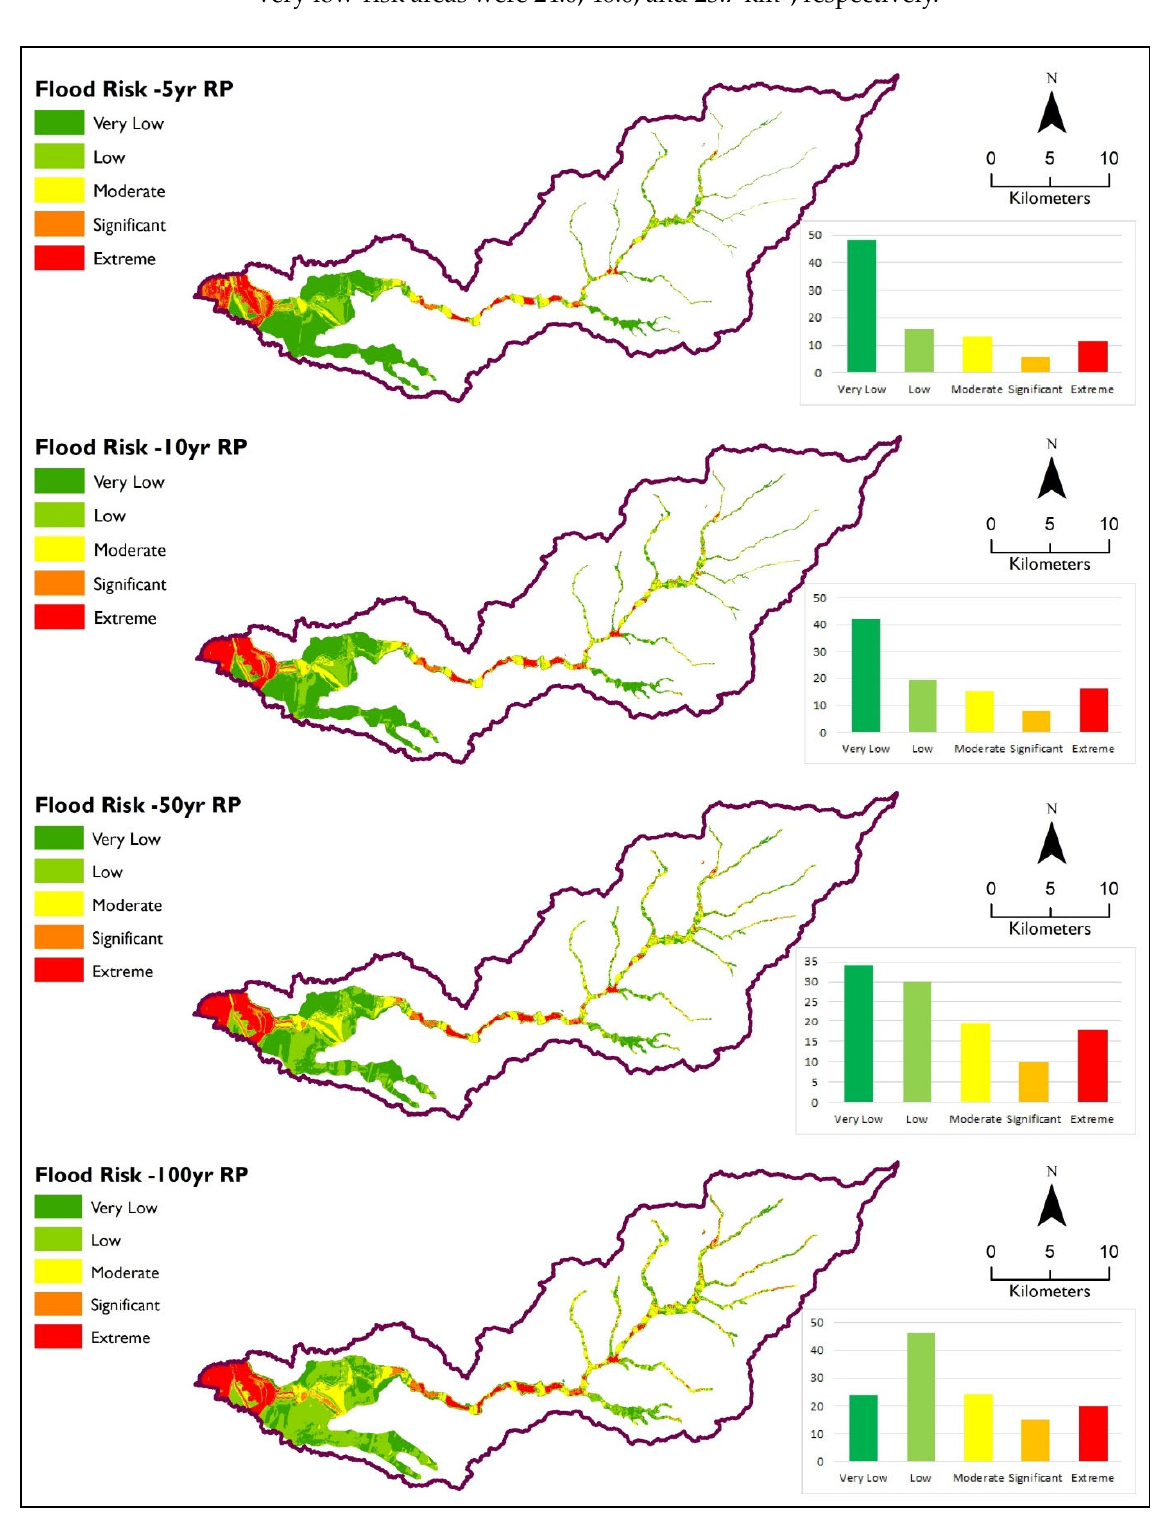
Figure 10. Flood Risk maps for different return periods.